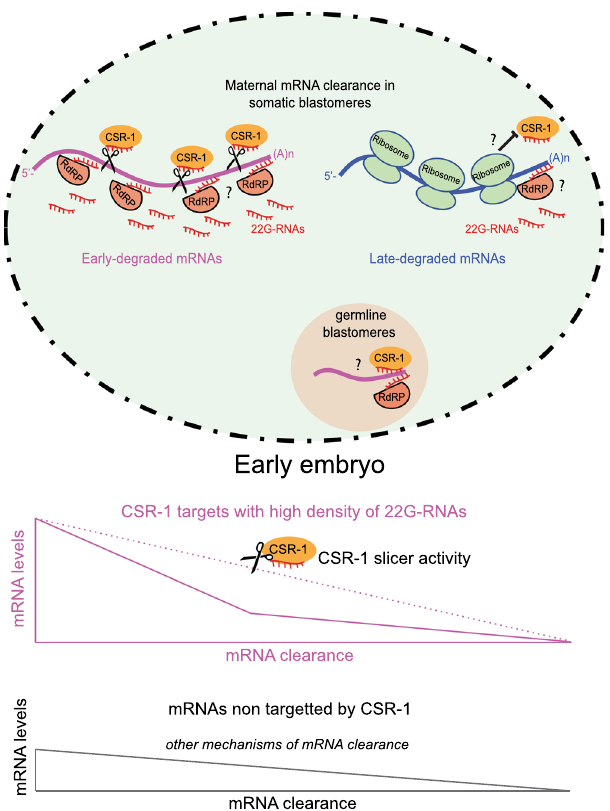
Fig. 7 Model illustrating CSR-1-dependent clearance of maternal mRNA in C. elegans embryos. During early embryogenesis, maternally inherited CSR-1 protein targets untranslated early-degraded maternal mRNAs for slicer-dependent degradation in somatic blastomeres. The presence of ribosomes on translated late-degraded maternal mRNAs might prevent CSR-1 accessibility and accumulation of new 22G-RNA antisense to the gene body. RNA in the germline blastomere might be protected from CSR-1 slicer activity. A fraction of maternal cleared RNAs not targeted by CSR-1 might be degraded by yet uncharacterized mechanisms. The CSR-1 pathway is an additional inherited mechanism that contributes to quicken the degradation of abundantly inherited mRNAs cleared during early